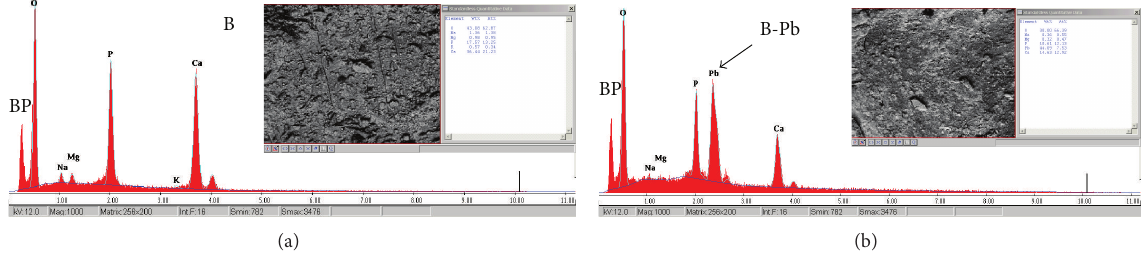
Figure 3: SEM-EDX spectrum of (a) B and (b) B-Pb.